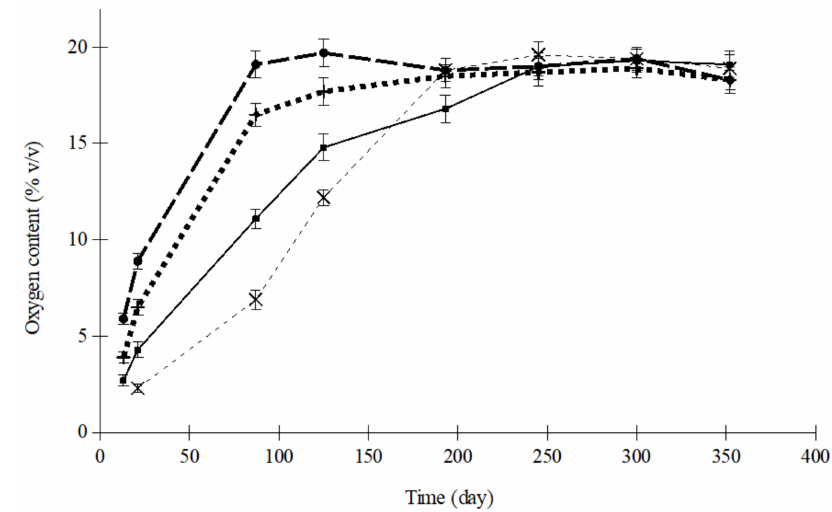
Figure 1. Evolution of O 2 concentration in trays containing dried apricots sealed with oriented polyamide/polyethylene (OPA/PE) 15/100 film and flushed with N2 ( × , 5 ◦ C; (cid:4) , 15 ◦ C; +, 25 ◦ C; • , 35 ◦